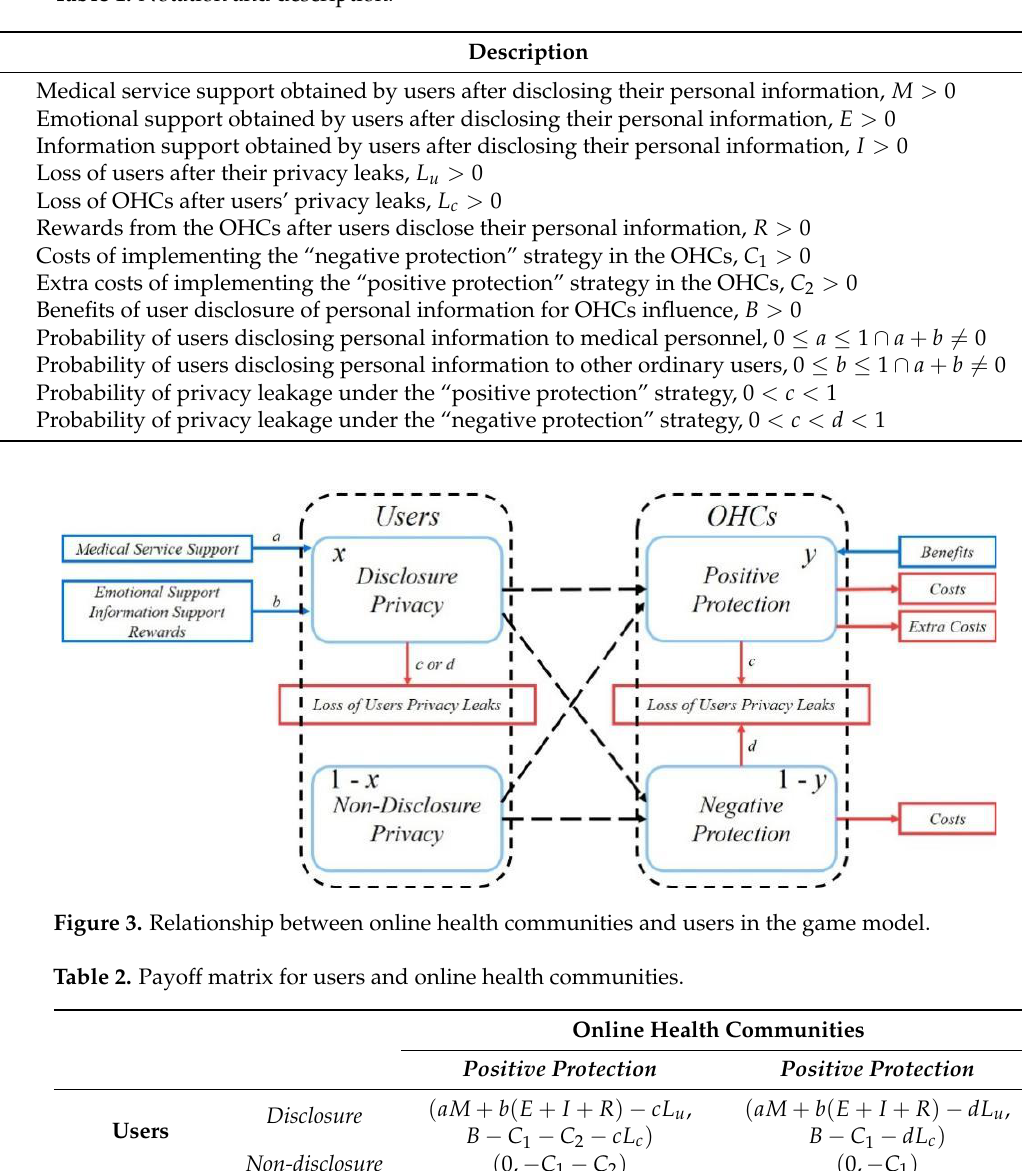
Table 1. Notation and description.